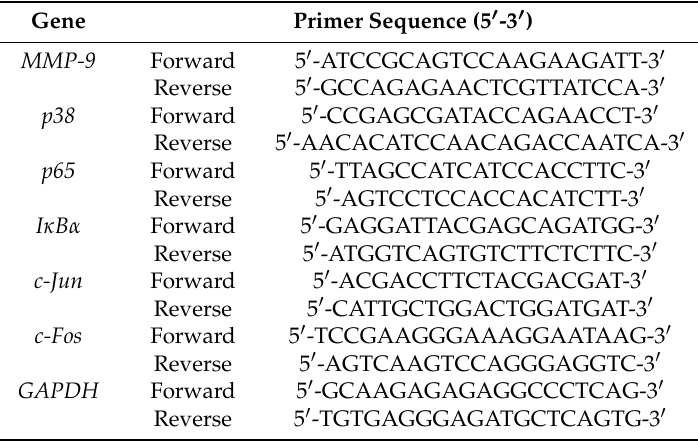
Table 1. Primer sequences for the target genes. MMP-9—matrix metalloproteinases-9; I κ B α —inhibitor of κ B α